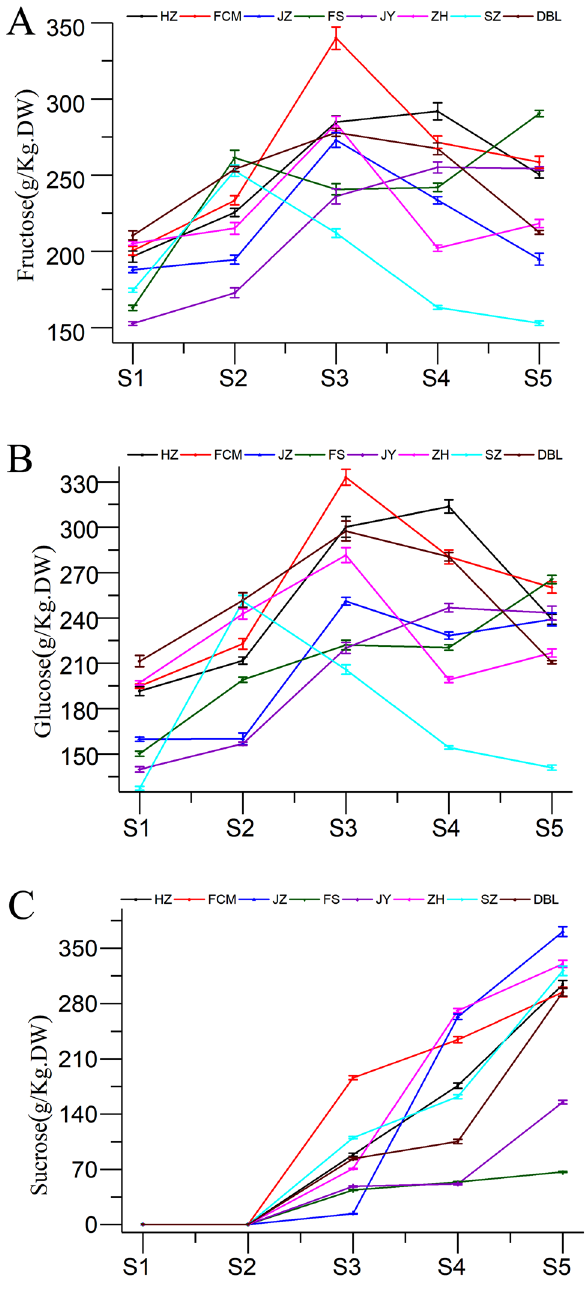
Figure 5. Changes in ( A ) fructose, ( B ) glucose, and ( C ) sucrose contents of jujube fruit at various developmental